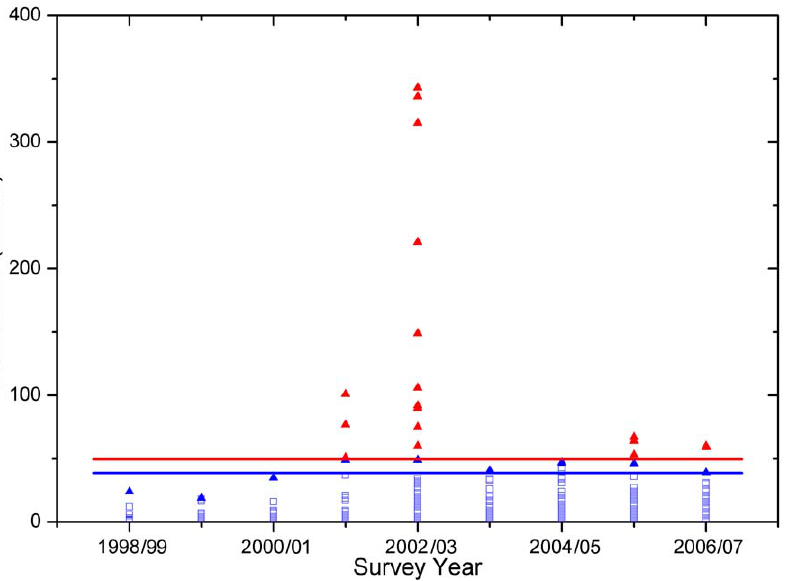
Figure 3. White syndrome abundance plotted against survey years, showing outbreak events (red triangle). Outbreak threshold determined by the iterative analysis (see Methods). Open blue squares correspond to disease observations interpreted as non-outbreak abundances, with the yearly-maximum non-outbreak events, all within one standard deviation of their mean, marked by blue triangles. The blue line shows the mean of non-outbreak yearly maxima (38.7 WS cases per 1500 m 2 ); the red line is the outbreak threshold, one standard deviation (10.9 WS cases per 1500 m 2 ) above the mean.